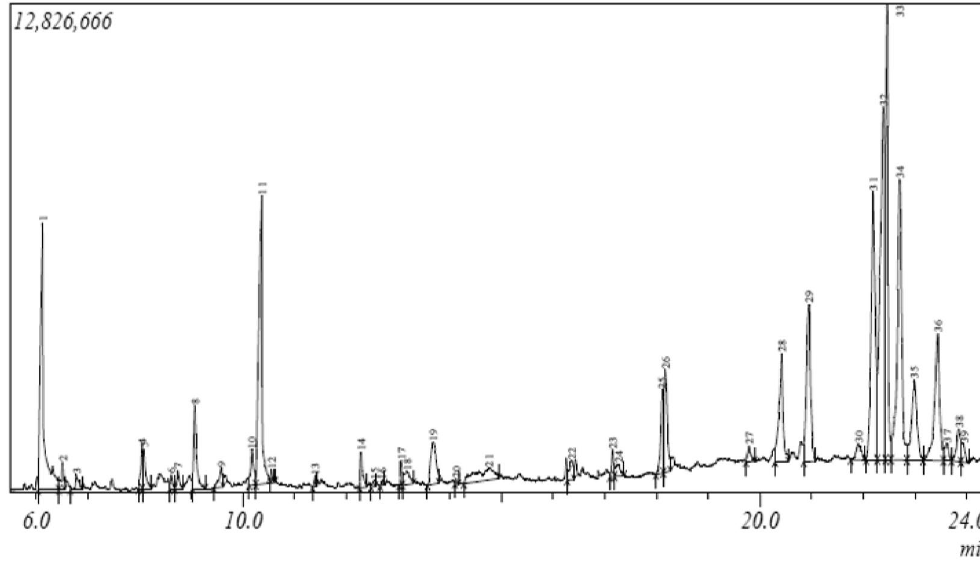
Figure 1. GC–MS Chromatogram of the phytoconstituents present in the methanol extract of Tamarindus